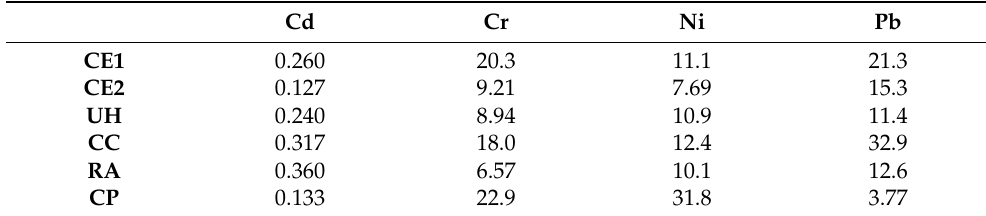
Table 5. Calculated background values (mg/kg) for each sampling site according to the iterative 2s-technique, proposed in